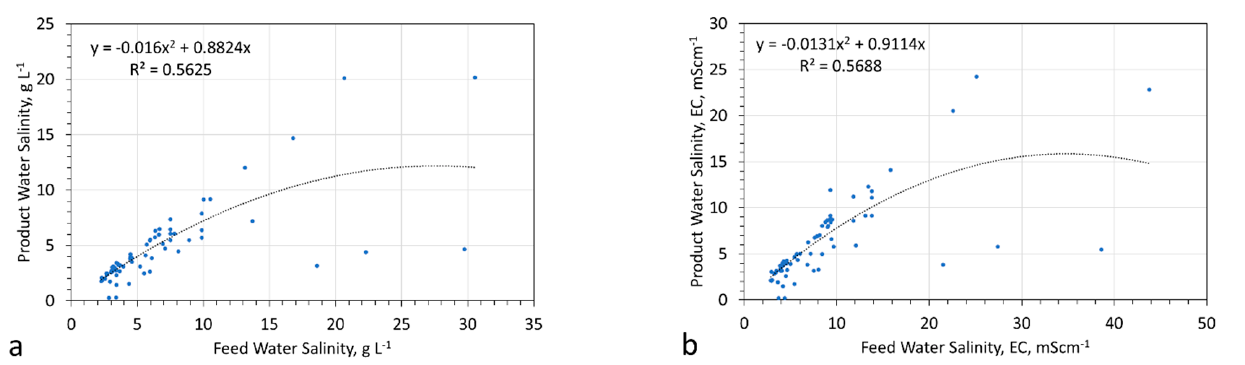
Figure 6. Feed water salinity vs. product water salinity. ( a ) Ion analysis, g L − 1 ; ( b ) electrical conductivity analysis, mScm − 1 .